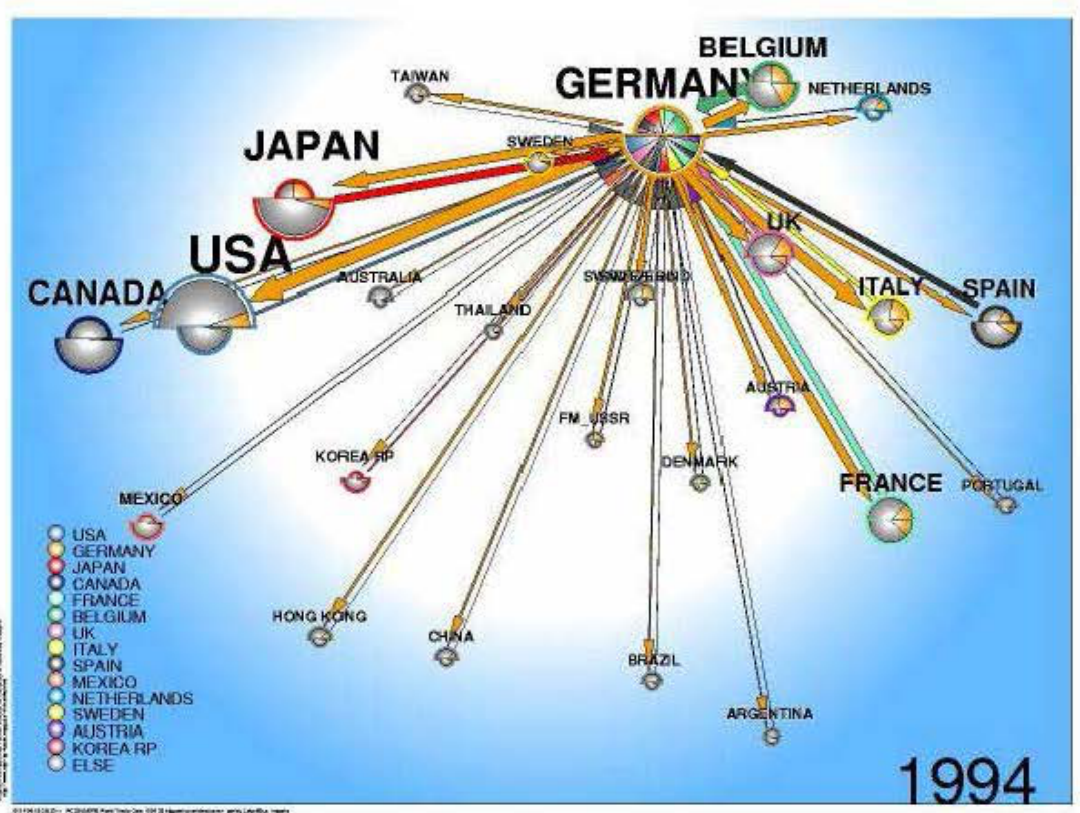
Figure 3: .Japan's (a) and C'..cnnanys (b) Participation in the WorldTrn:lc of Passenger Cats. Exports and li:nports by Destination imd their Relative Shares offhird Markets in